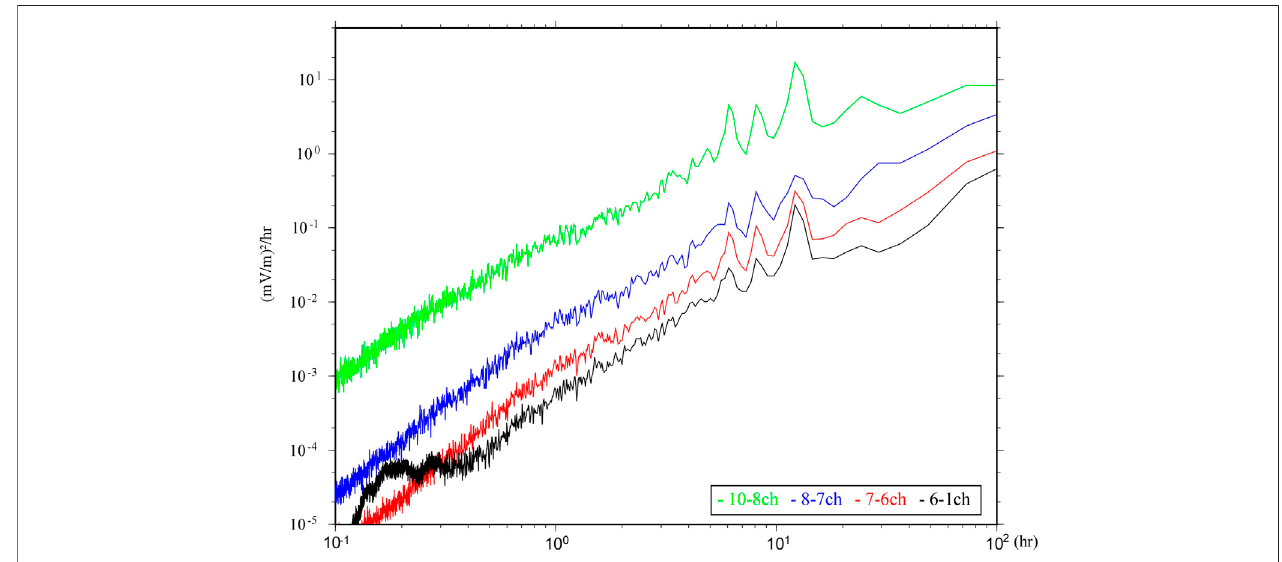
FIGURE 10 | Power spectra of electric fi elds of four electrode pairs calculated by FFT analysis. Colors are the same as those used for Figure 5 .